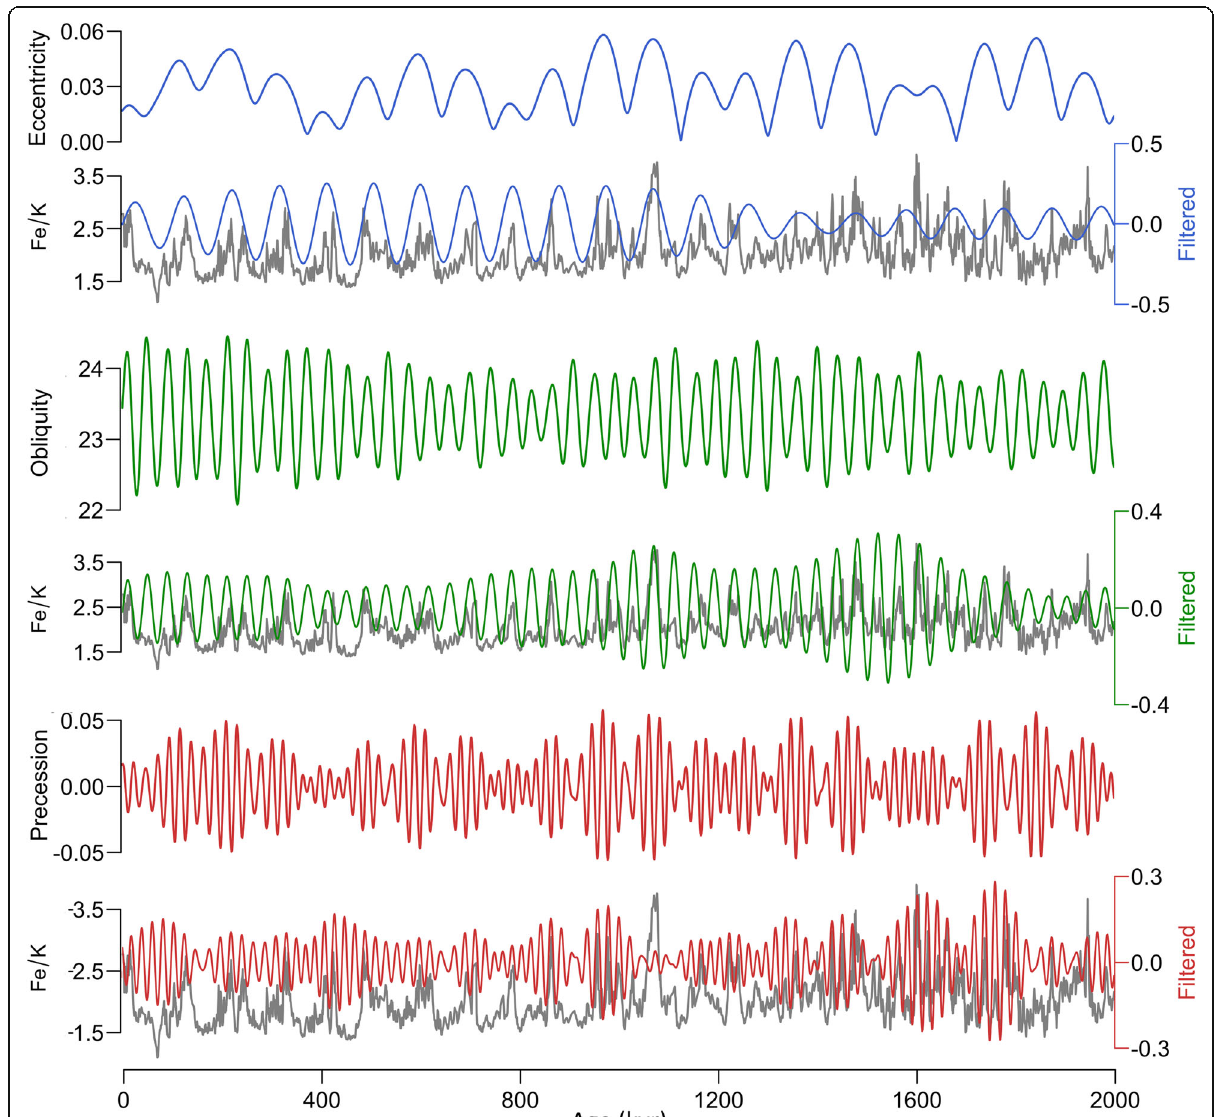
Fig. 9 Filtered components of eccentricity (blue), obliquity (green) and precession (red) from the Fe/K record compared with the respective orbital components by Laskar et al. (2004). Fe/K record is plotted in dark